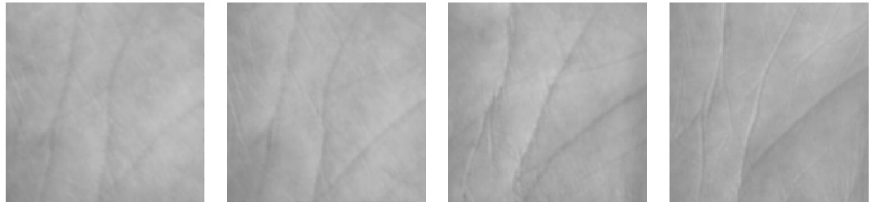
Figure 6. Sample images from the CASIA palmprint